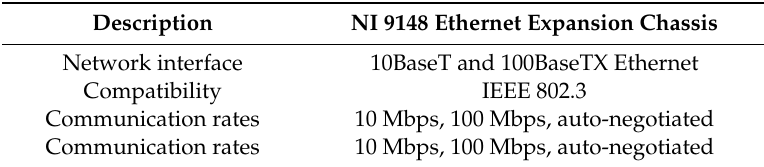
Table 2. NI 9148 Ethernet expansion